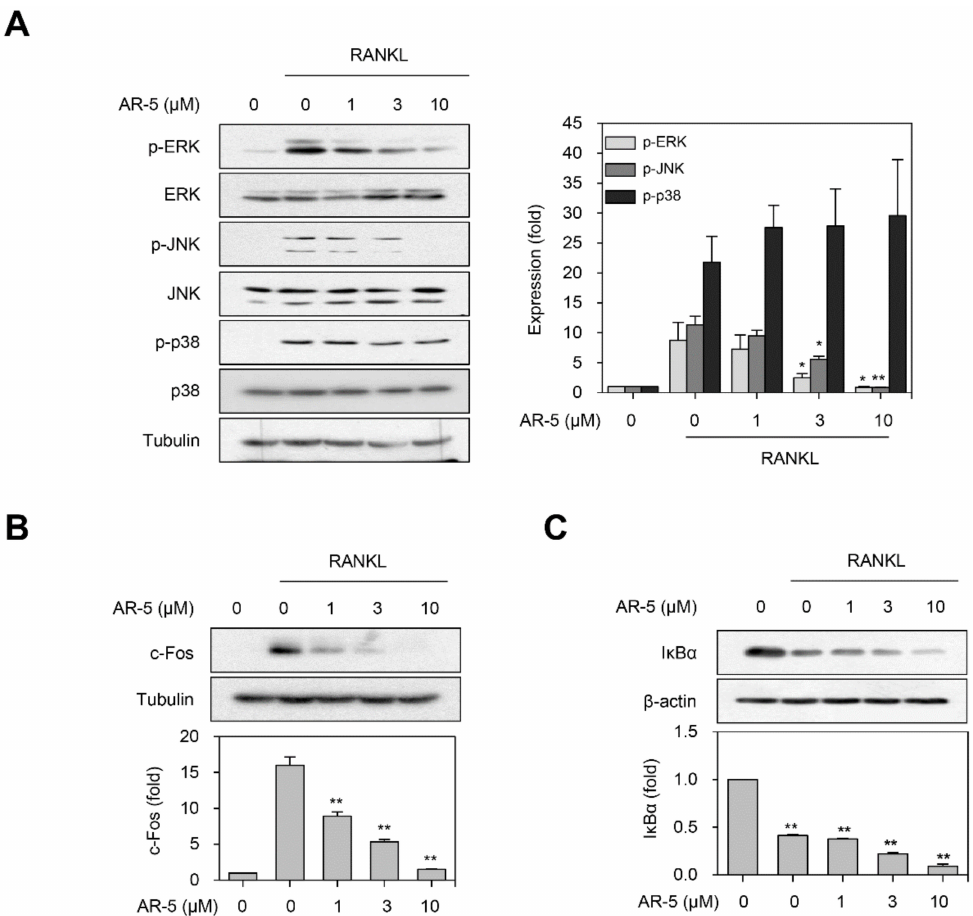
Figure 7. AR-5 inhibits RANKL-induced ERK and JNK phosphorylation, and c-Fos expression. ( A ) RAW264.7 cells were stimulated with RANKL in the presence of indicated concentrations of AR-5 for 10 min. Total lysates were prepared and western blotting was performed to determine the expression level of p-ERK, p-JNK, and p-p38 MAPKs. Densitometry analysis of p-ERK, p-p38, and p-JNK expression (normalized to ERK, p38, and JNK, respectively) expressed as the mean ± SE of three independent experiments (* p < 0.05 and ** p < 0.01, versus RANKL only-treated control, n = 3). ( B ) RAW264.7 were stimulated with RANKL (100 ng / mL) in the presence of the indicated concentrations of AR-5 for 24 h. The expression level of c-Fos was determined by Western blotting. Densitometry analysis of c-Fos expression (normalized to β -actin) expressed as the mean ± SE of three independent experiments (** p < 0.01, versus RANKL only-treated control, n = 3). ( C ) RAW264.7 cells were stimulated with RANKL (100 ng / mL) in the presence of indicated concentrations of AR-5 for 15 min. The expression level of I κ B α was determined by western blotting. Densitometry analysis of I κ B α expression (normalized to β -actin) expressed as the mean ± SE of three independent experiments (** p < 0.01, versus RANKL only-treated control, n =